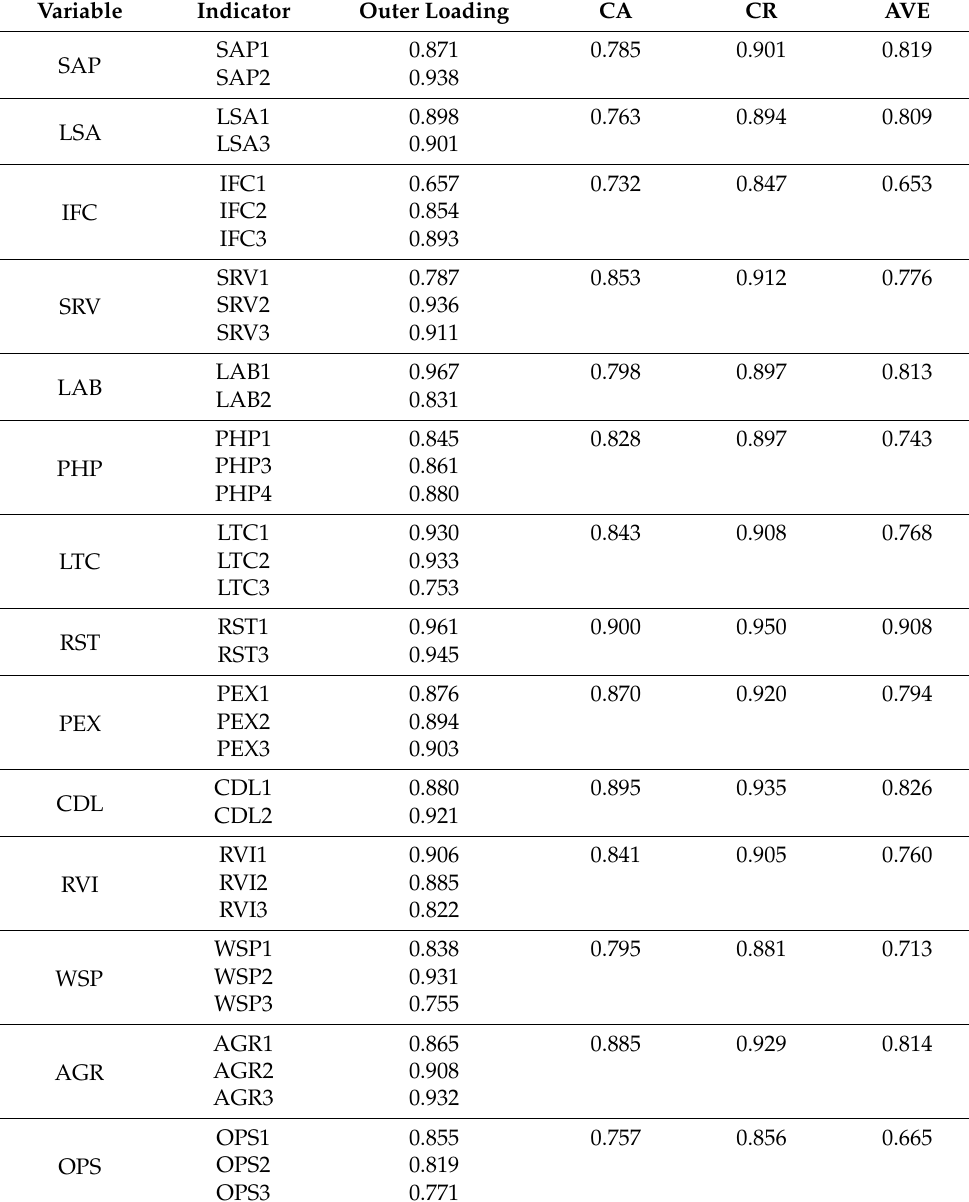
Table 4. Reliability and validity